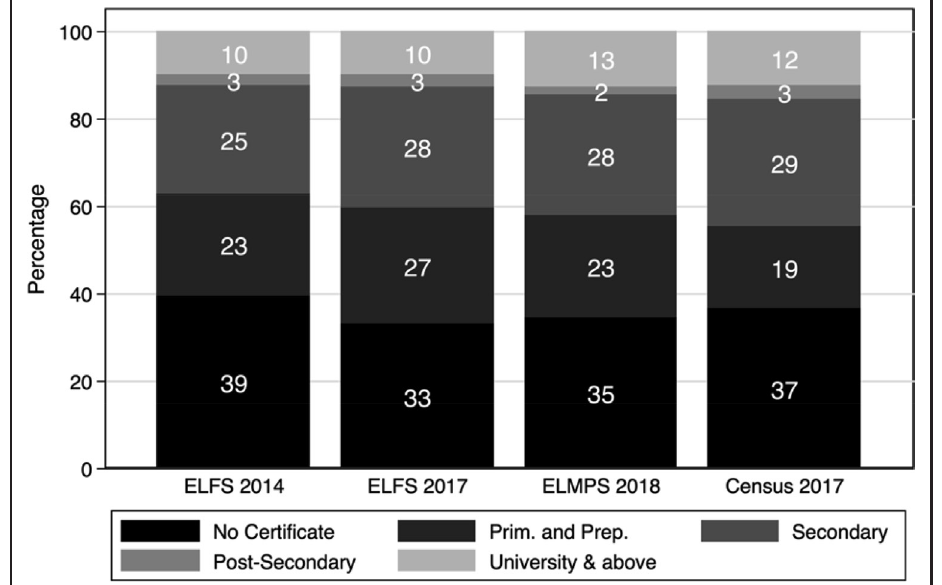
Figure 7 Educational attainment (percentage of individuals aged ≥ 10 years), by data source.